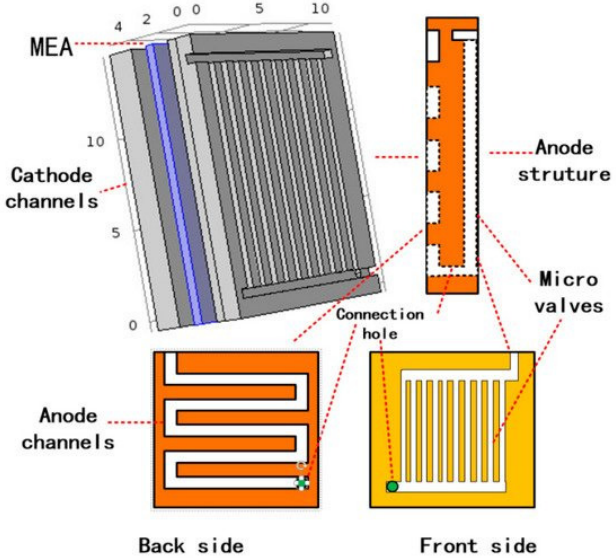
Figure 8. Schematic of the three-dimensional fuel cell model incorporating the microvalve structure [113]. ture